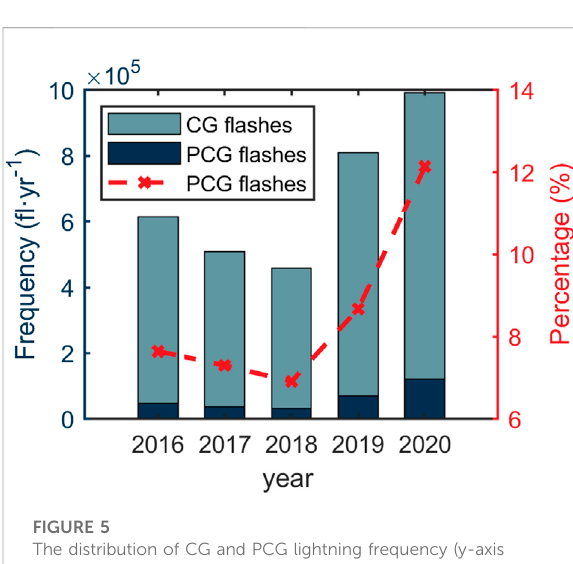
FIGURE 5 The distribution of CG and PCG lightning frequency (y-axis on the left) and the proportion of PCG lightning fl ashes (y-axis on the right) on the Yungui Plateau from 2016 to